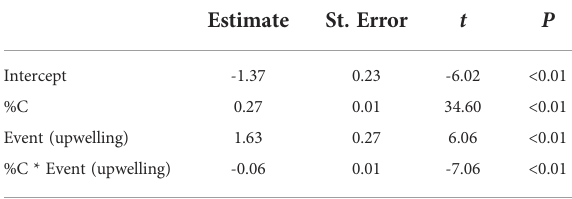
TABLE 2 Linear model testing the interaction between oceanographic events (downwelling and upwelling) and the elemental content of Carcinus maenas megalopae (%N as the response variable, %C and oceanographic event as explanatory variables).